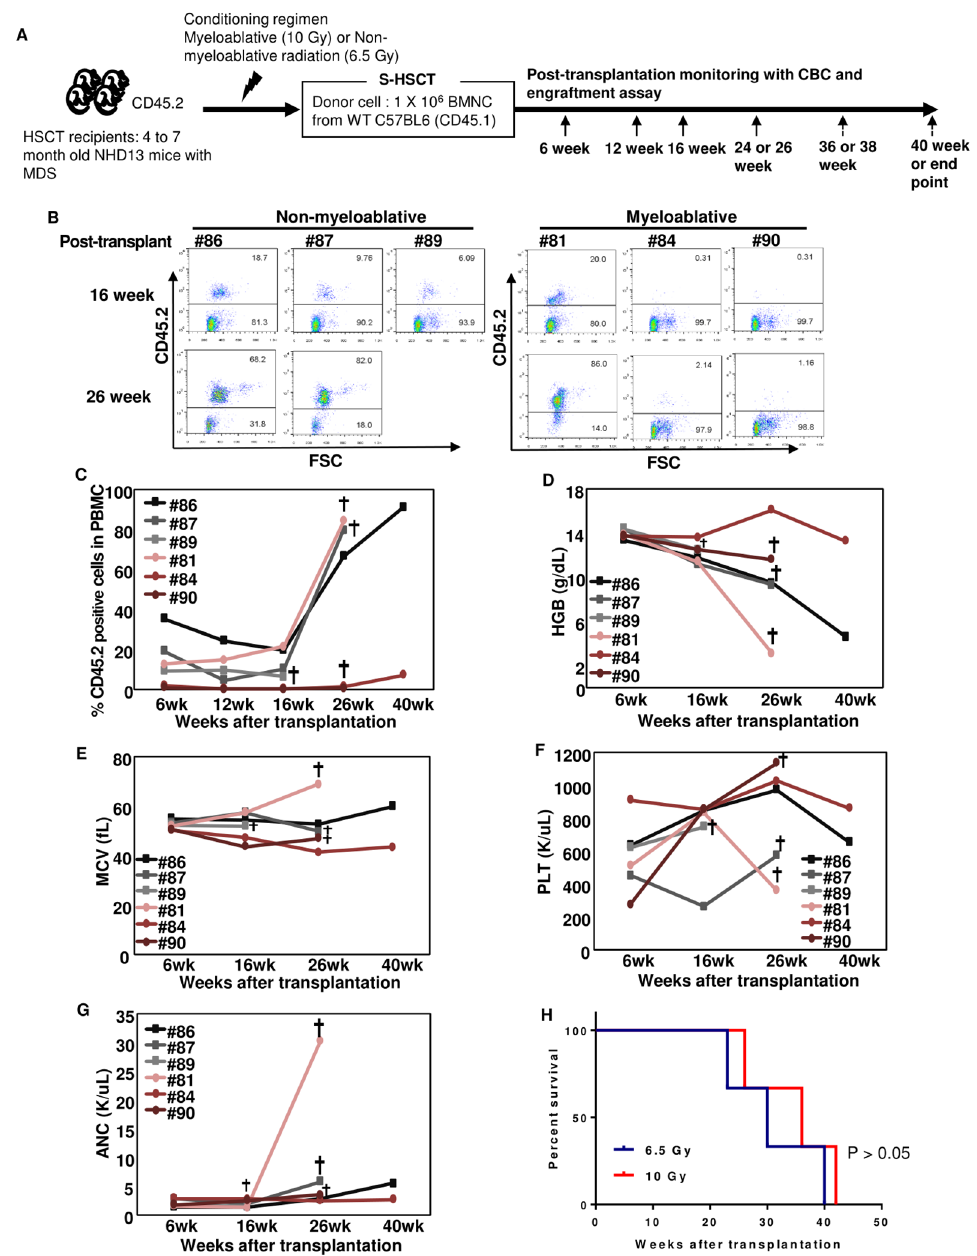
Fig 1. Syngeneic hematopoietic stem cell transplant (S-HSCT) as therapy for MDS. (A) Schematic illustration of S-HSCT experiment, using myeloablative (10 Gy) or non-myeloablative(6.5 Gy) total body irradiationas a conditioning regimen (B) Representative FACS profilesof individualrecipientsat 16 and 26 weeks post-transplant. CD45.2+ indicatescells derivedfrom the host. (C) CD45.2+ cells from individual recipients; increasing CD45.2+cells indicaterelapse of host (MDS-derived) hematopoiesis. (D) Hemoglobin changesfollowingS-HSCT. (E) MCV, Mean corpuscular volume. (F) PLT, platelet count. (G) ANC, absolute neutrophil count. (H) Survivalcurve after HSCT. The sword symbol indicatesdeath of the recipient.